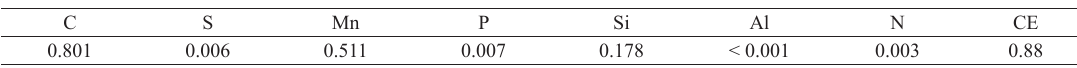
Figure 2. Dilatometry curve of a) heating and b) cooling. Table 1. Chemical composition of the samples (wt.